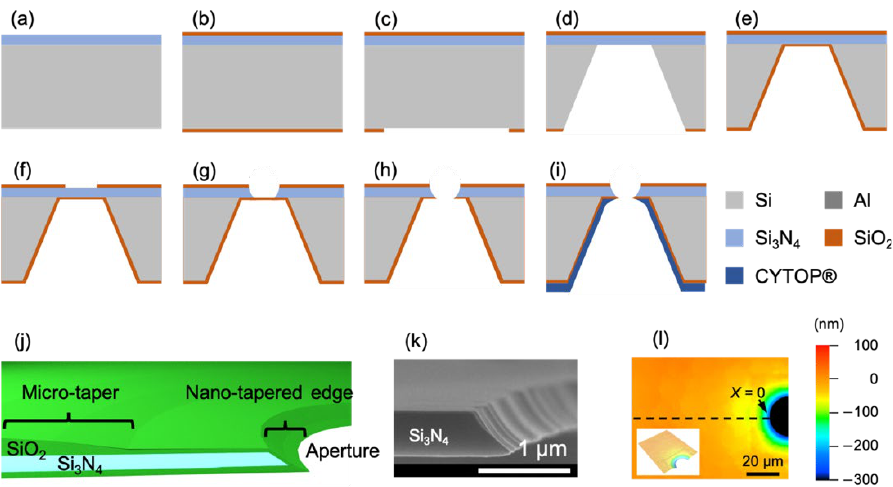
Figure 3. Fabrication process ( a – i ), structural scheme ( j ), scanning electron microscopic image ( k ), and height profile ( l ) of the Si chip used to produce BLM. After the aperture was formed in the Si chip ( h ), fluoropolymer CYTOP® (CTL-809M) was coated on an entire chip to reduce the capacitance of the chip. Reprinted with permission from Refs. [11,12].